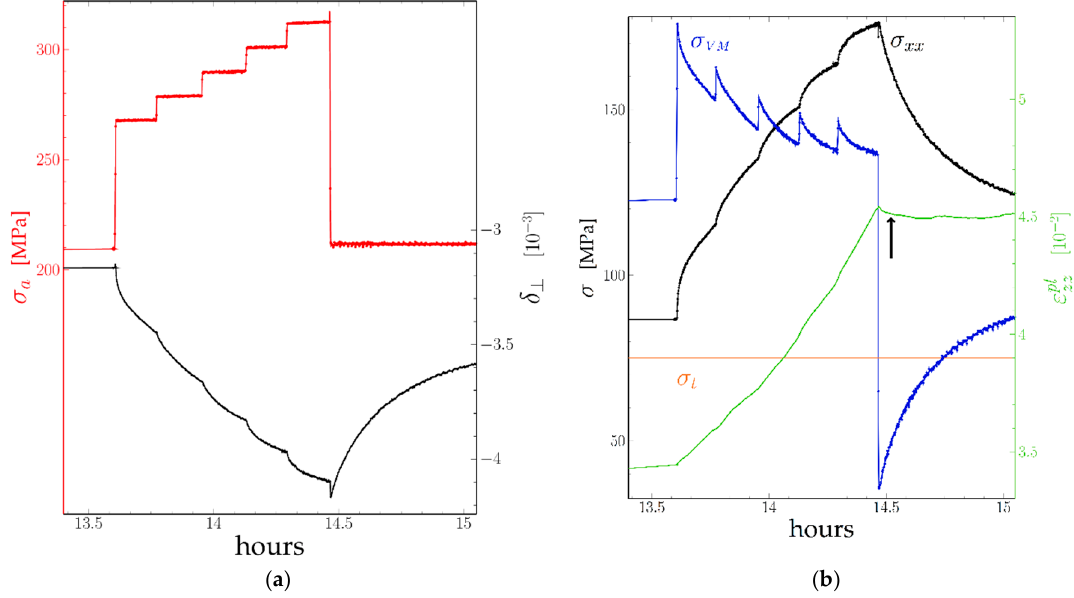
Figure 6. Detail between 13 h 30 and 15 h of the creep test of a sample with an initial “ small ” microstructure at 970 ◦ C: ( a ) applied stress σ a (red), δ ⊥ , (black), b ) σ xx (black) σ VM (blue) and plastic strain ε pl zz in